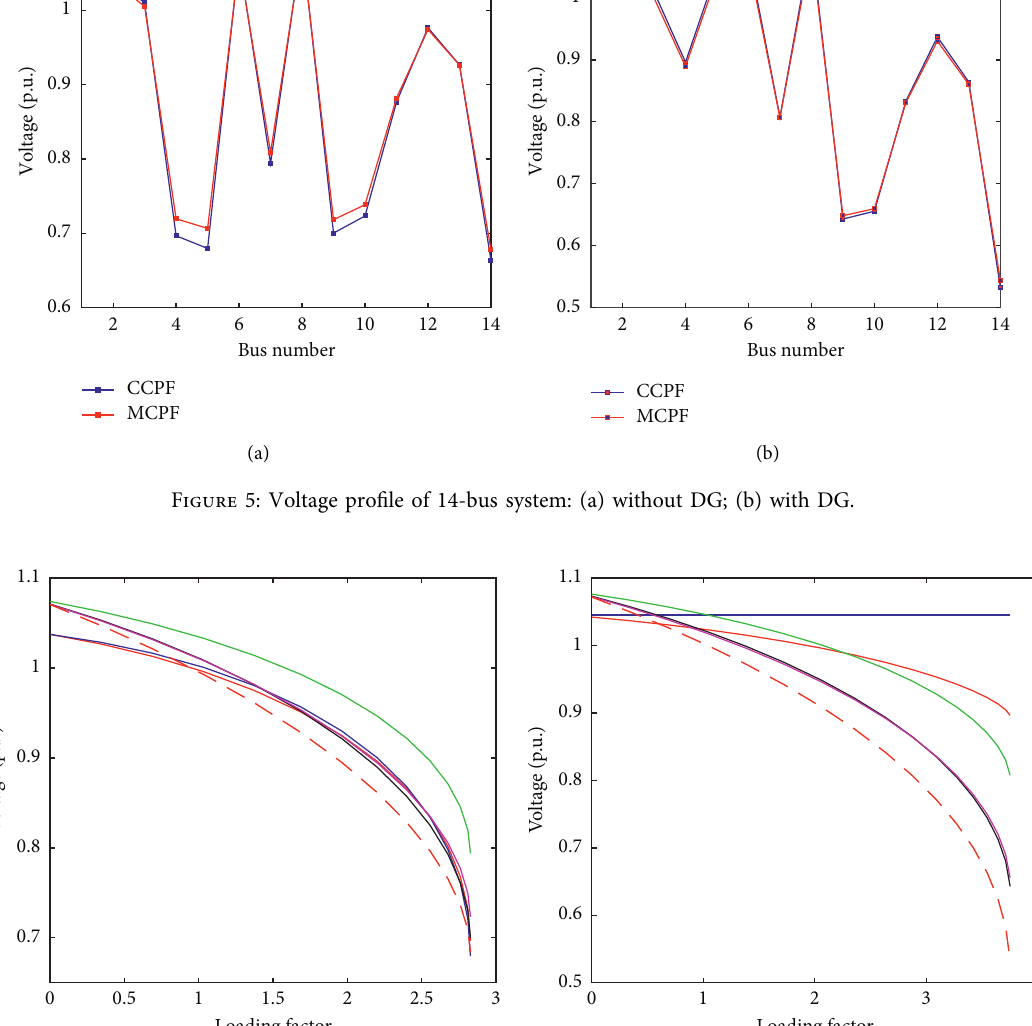
verify the proposed method, the IEEE 57-bus system can be chosen as a medium-scale system. This system has 7 syn- chronous machines with IEEE type-1 exciters, three of which are synchronous compensators, 64 buses, 65 transmission lines, 22 transformers, and 42 constant impedance loads. The total load demand is 1,250.8 MW and 336.4 MVAr. More